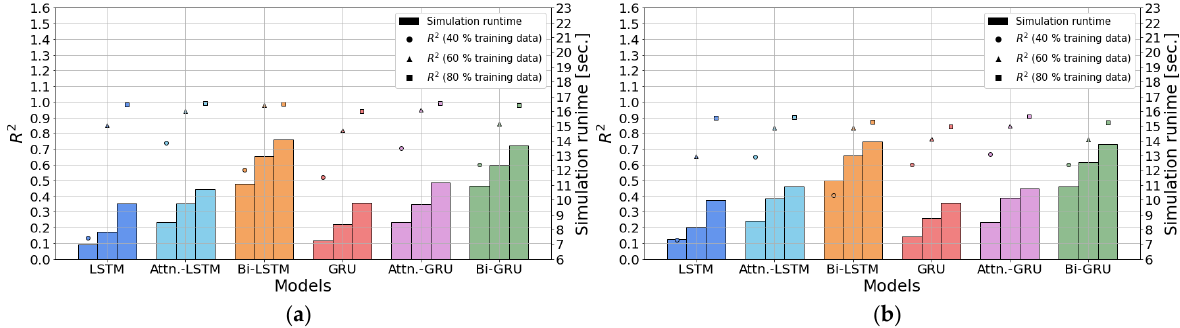
Figure 14. Comparison of the average value of the coefficient of determination for each RNN model according to the average simulation runtime: ( a ) Normal vibrations; ( b ) Abnormal vibrations.